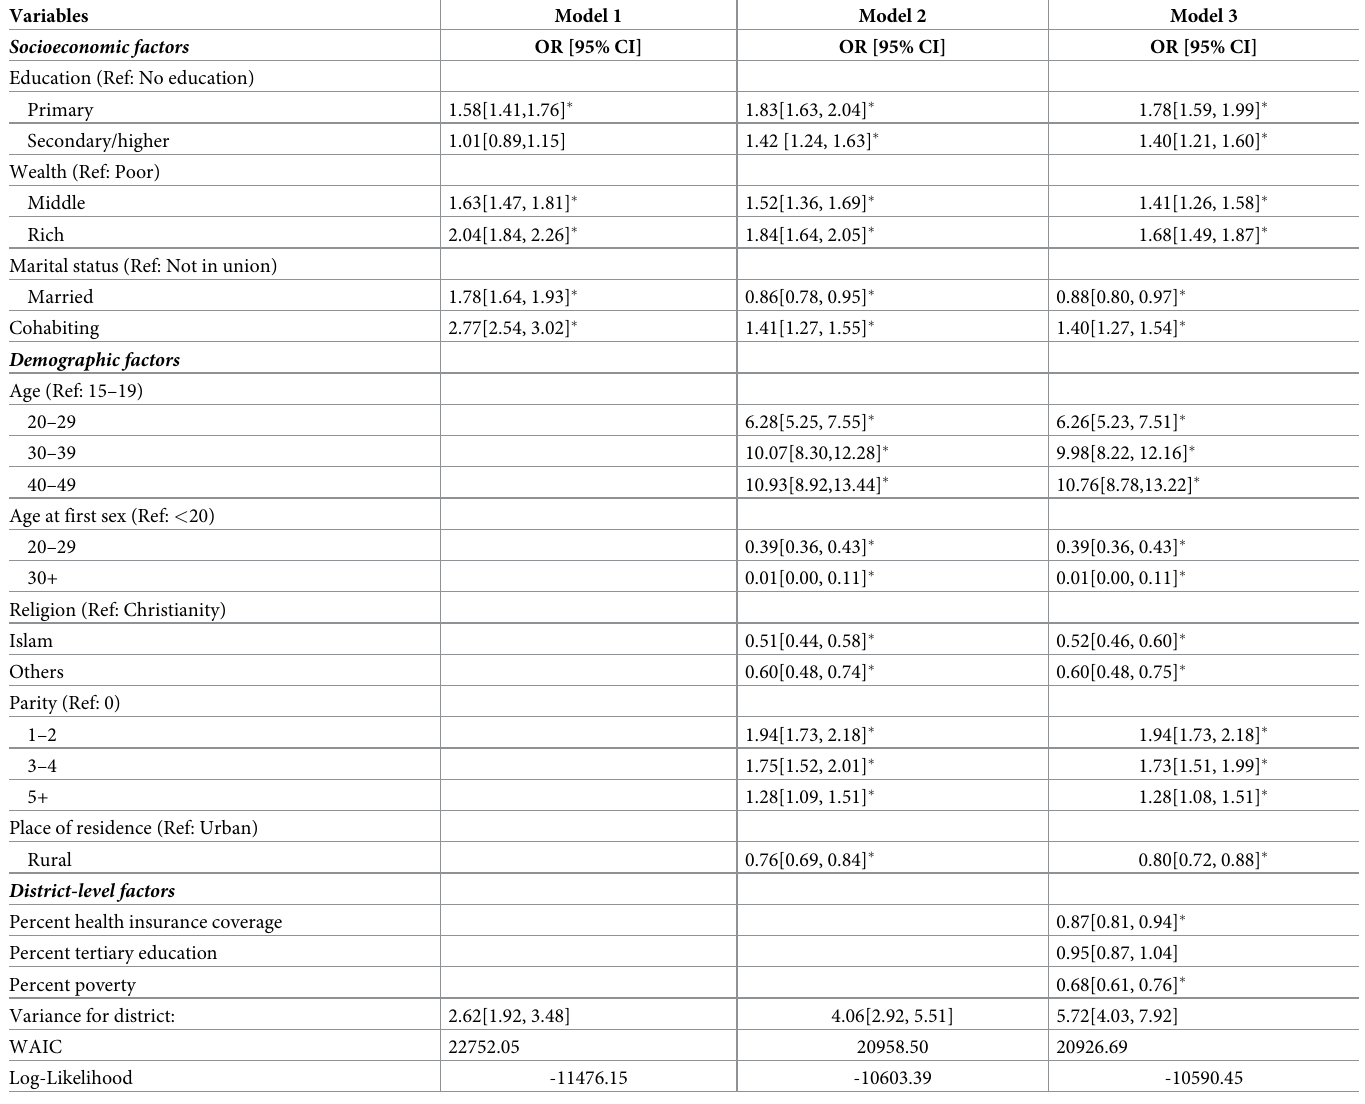
Table 2. Bayesian multilevel logistic regression analysis of induced abortion in